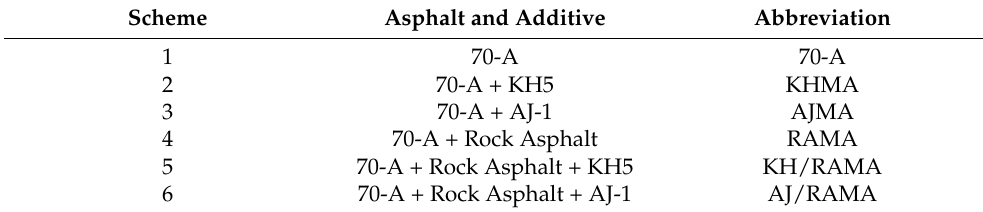
Table 3. Scheme of anti-stripping measures for asphalt